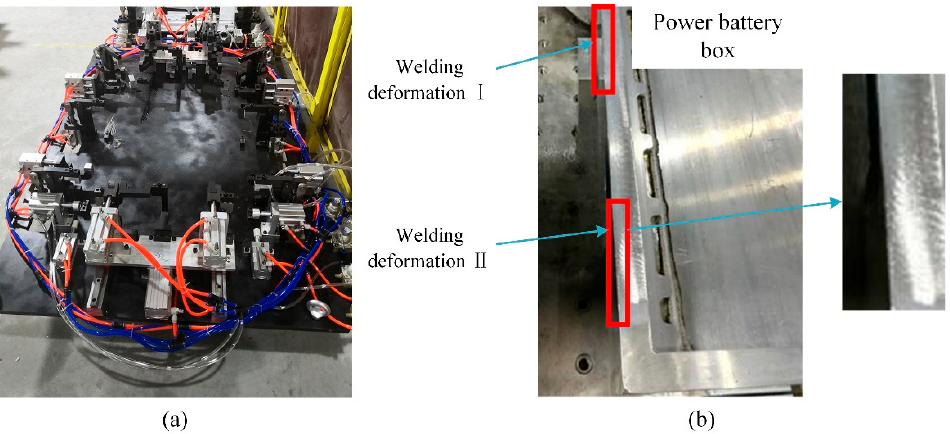
Figure 15. Welding fixture and deformation diagram after welding: ( a ) the welding clamp; ( b ) weld- ing experiment results.